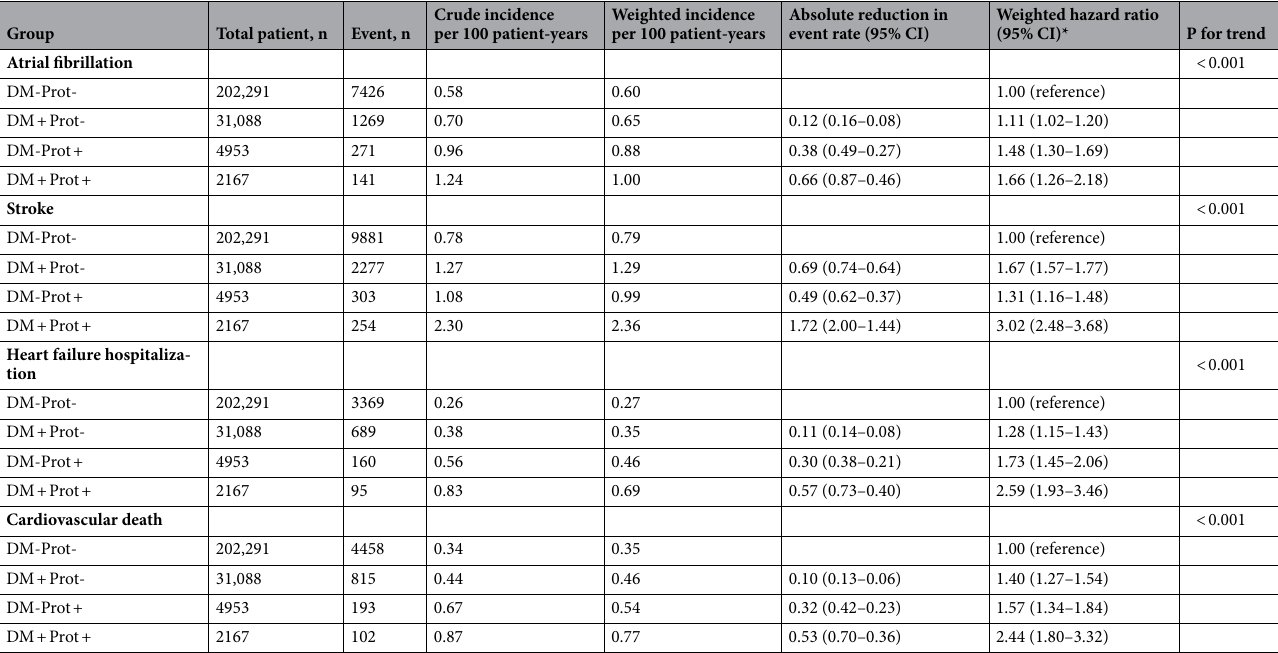
Table 2. Incidences of outcomes in the Study Cohort. *After inverse probability of treatment weighting. Covariates adjusted for age, sex, BMI, smoking, alcohol, hypertension, dyslipidemia, chronic kidney